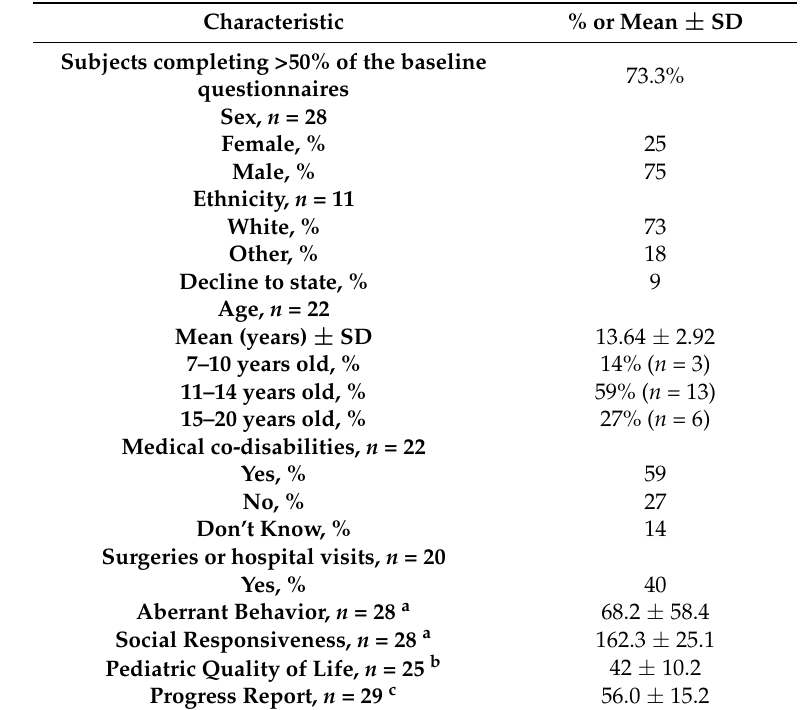
Table 1. Baseline characteristics of study